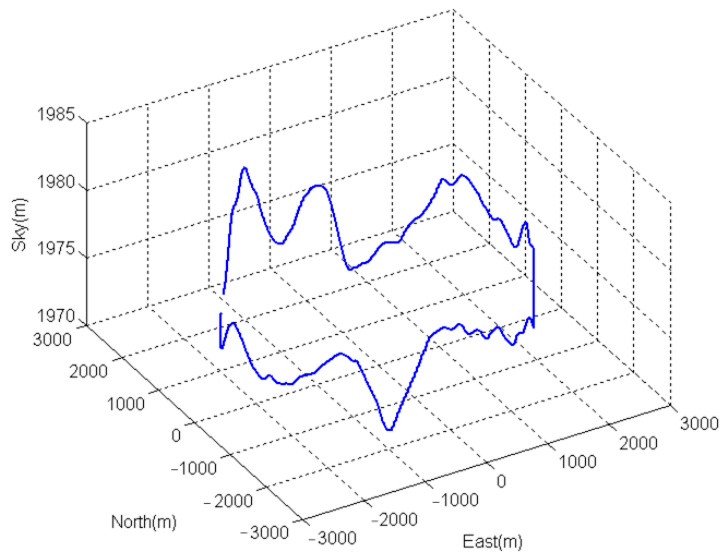
Figure 23. 3D flight trajectory of the radar platform.